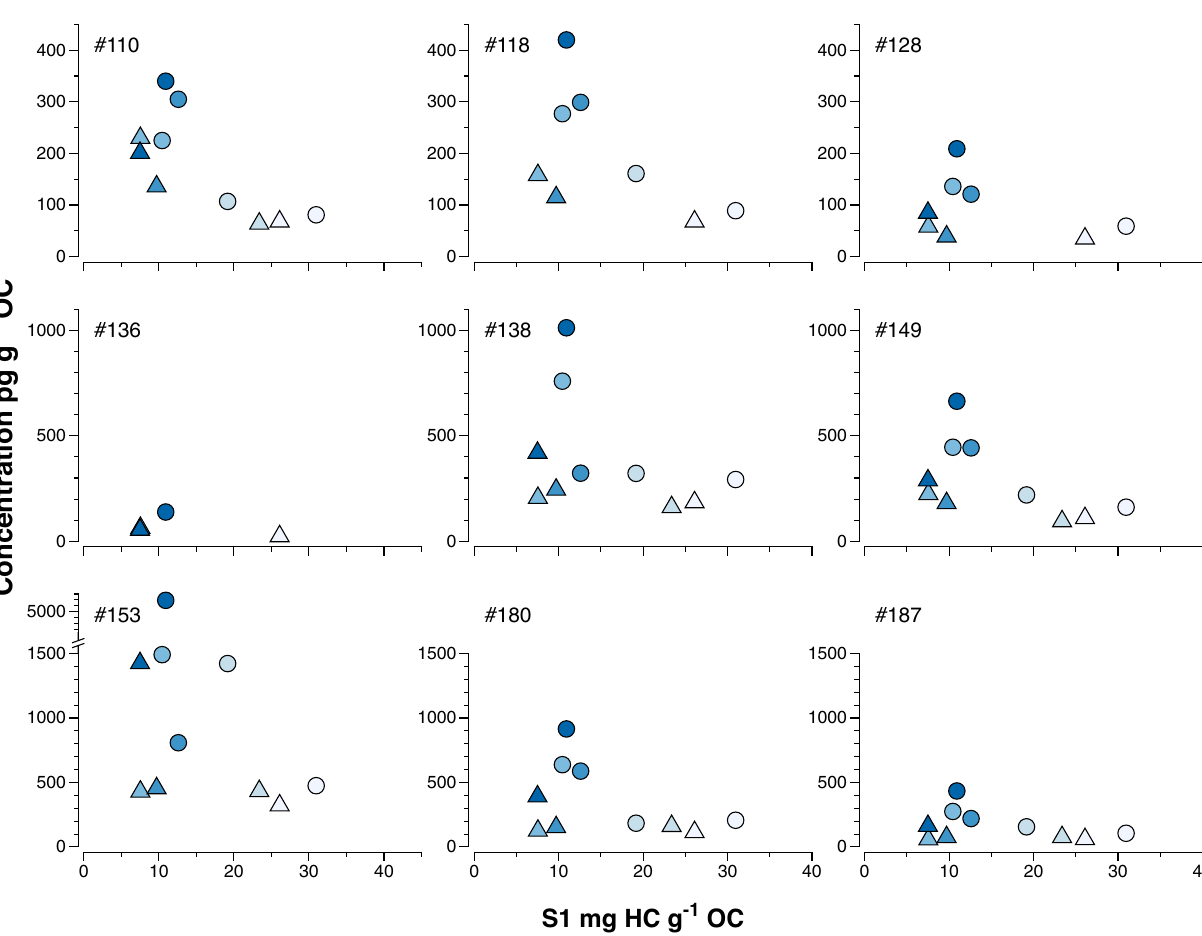
(upper40mm). Sedimentconcentrationsinlayer0 – 20mmaredepictedbycircles and in layer 20 – 40mm by triangles. Colors from bright to dark indicate water depth from shallow to